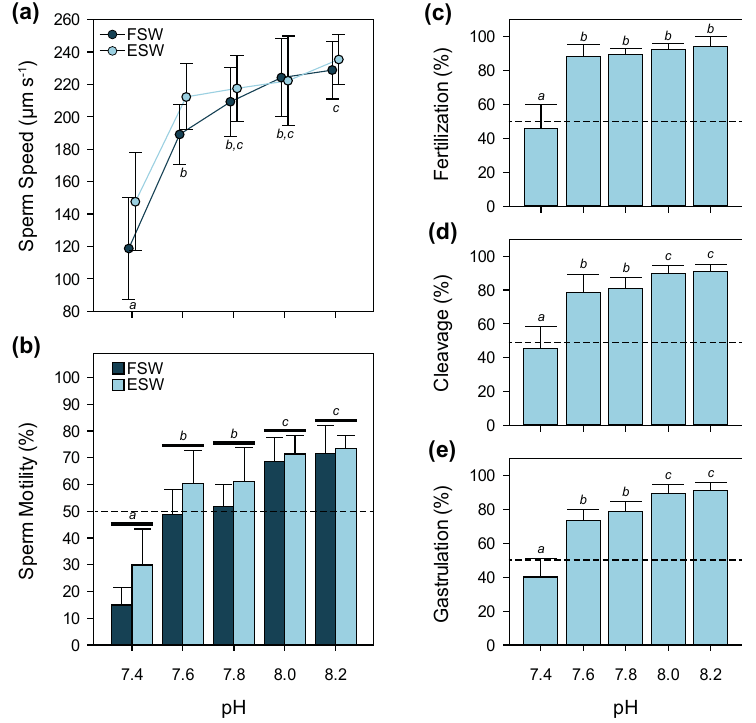
Figure 4. Influence of pH on sperm behavior, fertilization, and early development: ( a ) sperm speed (points slightly displaced for clarity); ( b ) proportion of motile sperm, and proportion of eggs undergoing ( c ) fertilization; ( d ) cleavage, and ( e ) gastrulation. Letters above error bars (±SD) indicate significant differences based on post hoc pairwise comparisons with corrected p-values. FSW = 0.2- μ m filtered seawater (control); ESW = solution with water-soluble egg extract.